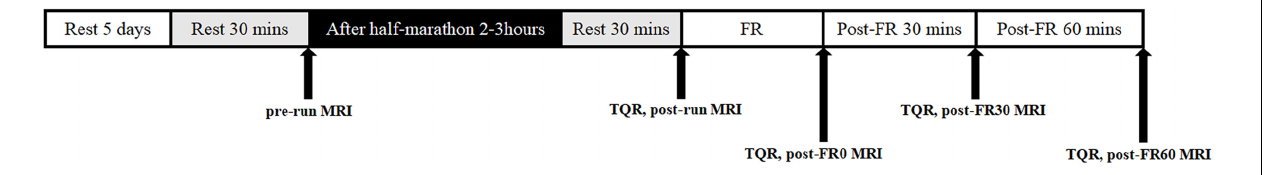
FIGURE 1 | Example of the experimental protocol. FR, foam rolling; pre-run, baseline; post-run, 2–3 h after half-marathon running; post-FR0, immediately following FR; post-FR30, 30 min after FR; post-FR60, 30 min after FR; TQR, Total Quality Recovery scale; MRI, magnetic resonance imaging examination. 400 (2), 500 (2), 800 (3) s/mm 2 ; scan time 5 min and 20 s] in 3 orthogonal directions were subsequently collected in axial